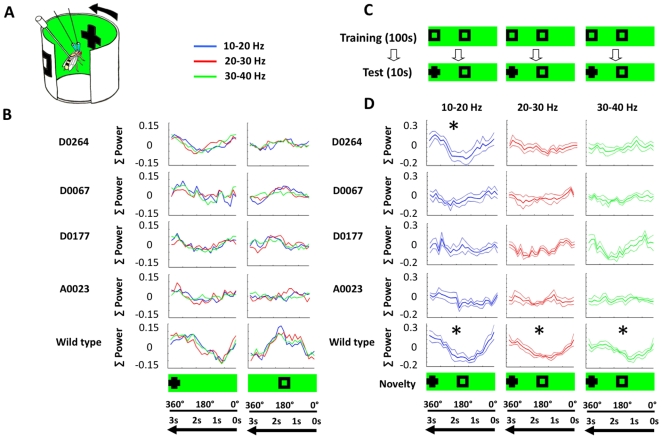
Brain responses.A. Recording arena. The tethered fly is implanted with two recording electrodes and placed in the center of an LED arena on which a moving visual panorama can be displayed. Arrow: visual panorama rotation. B. Baseline responses to the visual objects presented alone, for the 3 top optomotor performers (D0264 (N = 6), D0067 (N = 6), and D0177 (N = 5), for an average optomotor performer, A0023 (N = 4), and for wild type (N = 4). Average responses in three frequency ranges (10–20 Hz, blue; 20–30 Hz, red; 30–40 Hz, green) are shown. The matching position of either object (cross or square) is indicated in the schema at the bottom. Σ Power is the zero-meaned, normalized power, summed within each frequency domain and averaged among individuals within a genotype. C. Novelty paradigm. Flies are exposed to two identical squares (in black, depicted on the unwrapped green panorama) for 100 s (Training), immediately followed by presentation of a cross and a square at the same positions (Test). This is repeated 5 times to generate averaged responses for the 10 s following a novelty transition. D. Brain responses to novelty. Novelty responses (±s.e.m.) in four LTM mutants across three LFP frequency domains (blue: 10–20 Hz; red: 20–30 Hz; green: 30–40 Hz). The matching position of either object (cross and square) is indicated in the schema at the bottom. * = significantly different (P<0.05, by Wilcoxon rank sum) responses to either object (between summed power for the six sectors when the cross is in front versus the opposing sectors when the square is in front of the fly; See Methods). Σ Power, summed power of all frequencies in said frequency domain. N = 4 flies per genotype. Baseline responses for the 10 s immediately preceding novelty are shown in Figure S3.